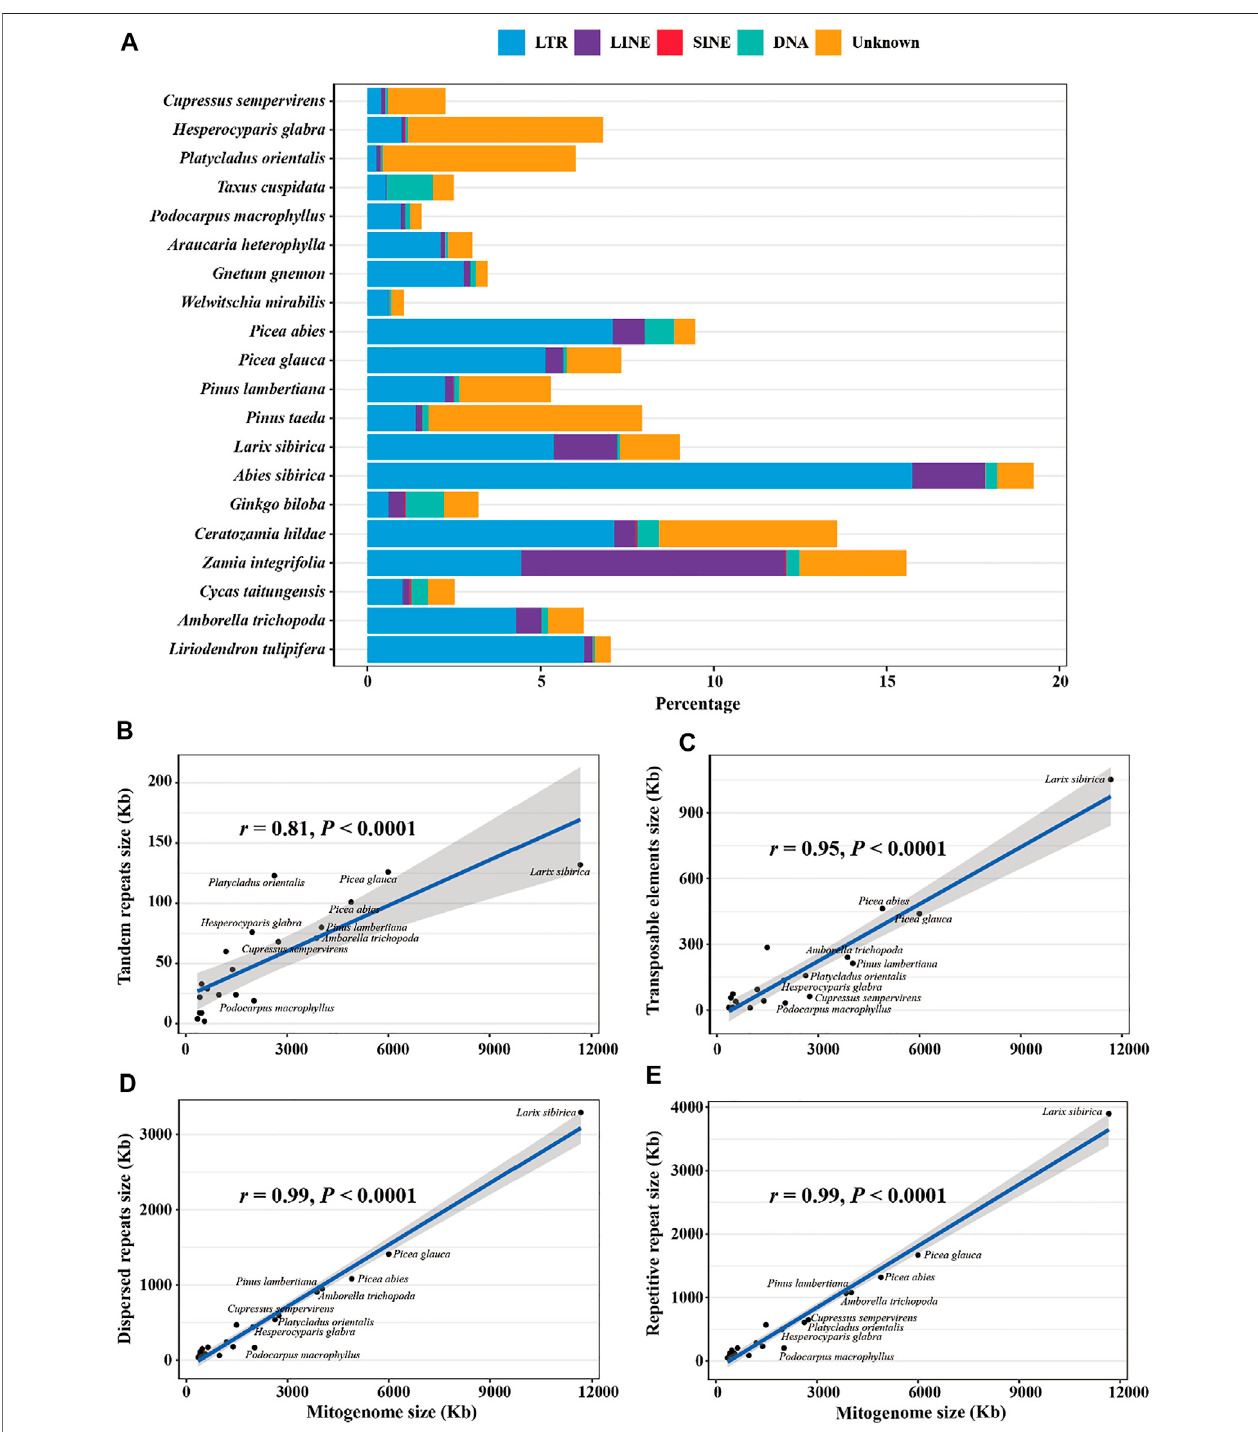
FIGURE 4 | Composition of repetitive sequences in gymnosperm mitogenomes. (A) The proportion of TE classes identi fi ed in each genome. LTR, long terminal repeat; LINE, long interspersed nuclear element; SINE, short interspersed element; DNA, DNA transposable element; Unknown, unclassi fi ed transposable element. (B) Correlation between mitogenome size and tandem repeat size, (C) TE size, (D) dispersed repeat size, and (E) repetitive sequence size. The blue line represents the regression fi tting with a linear model. The grey shadow is the 95% con fi dence interval of the linear regression.